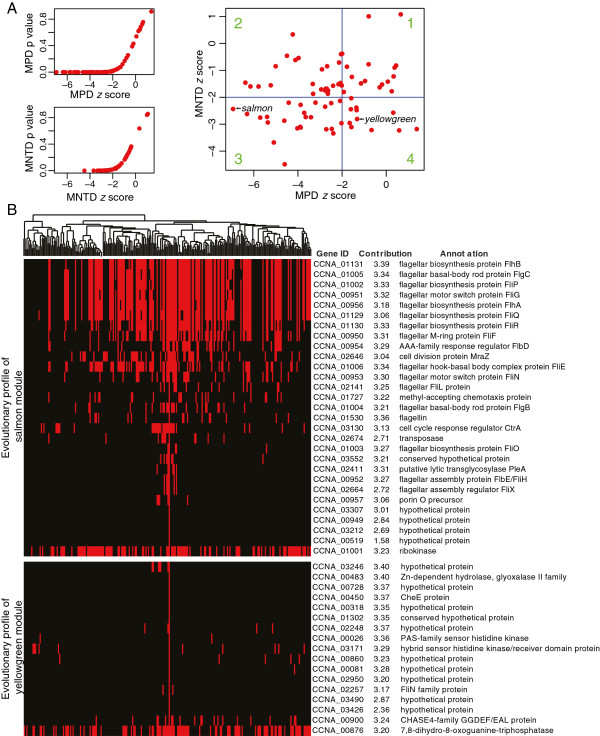
Phylogenetic analysis of co-expression modules. (A) Mean pairwise distance (MPD) and mean nearest taxon distance (MNTD) were used to measure the tree-wide and tip-level clustering of each module, respectively. The two small panels on the left show that -2 is a significant threshold (with p=0.01) for both MPD and MNTD z scores. In the right panel, modules (red dots) are displayed in 4 quadrants. Modules in the 2nd and 3rd quadrants have significant low MPD values (< -2), indicating that their genes display tree-wide clustering. Modules in the 4th quadrant have significantly low MNTD (<-2) but not significant MPD values, indicating that their genes exhibit tip-level clustering. (B) Phylogenetic profiles showing the distribution of the member genes of the salmon and yellowgreen modules shown here as examples. The dendrogram on the top of the module profile is the phylogenetic tree based on 16 s rRNA of 236 species selected in an unbiased fashion (see methods). The solid vertical red line corresponds to C. crescentus.